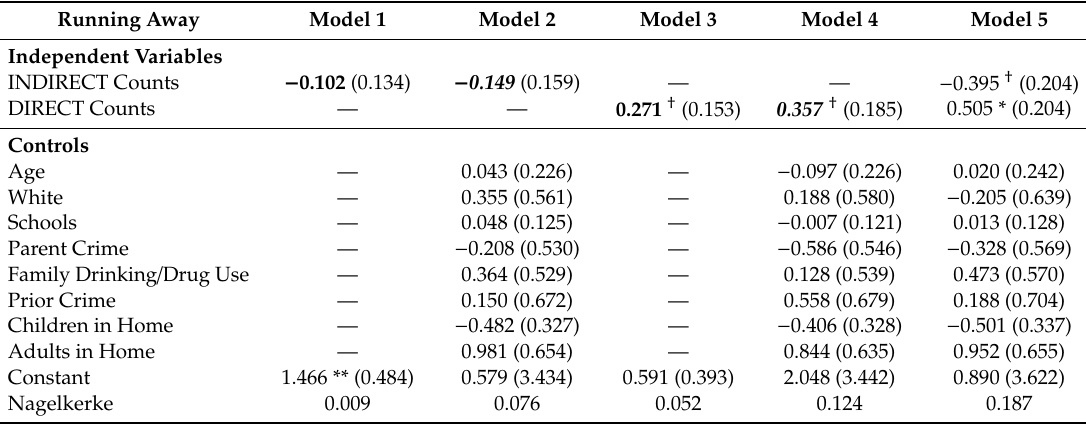
Table 4. The e ff ect of indirect and direct victimization counts on running